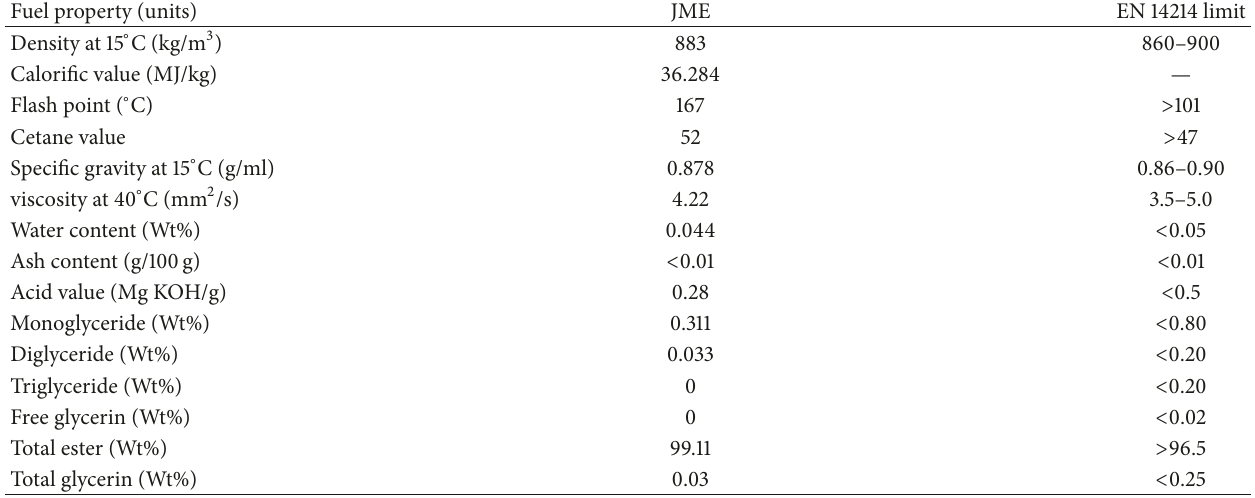
Table 7: JME fuel